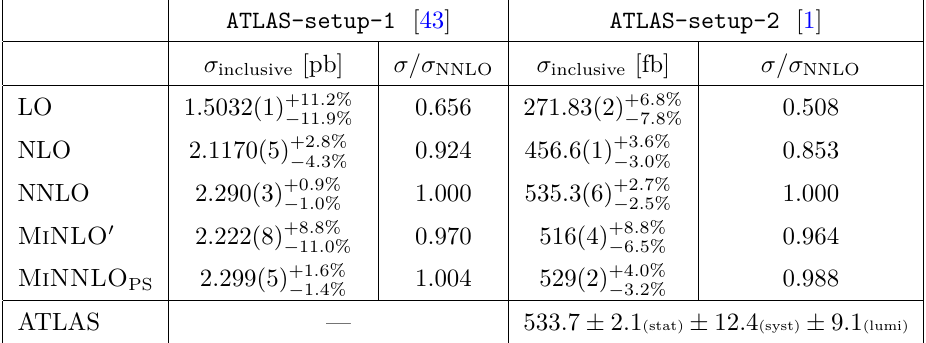
Table 2. Predictions for fiducial cross sections of Zγ production at LO, NLO, and NNLO, as well as using the MiNLO 0 and MiNNLO calculations, in the two ATLAS setups. For comparison, a PS column with the ratio to the NNLO cross section is shown. In the last row the ATLAS measurement of ref. [1] is